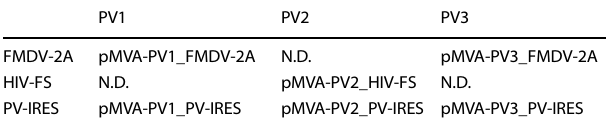
Table 1. Matrix of plasmids tested for transient expression by transfection into GMK cells. Expression of the P1 genes is regulated by the T7 promoter, with the T7 polymerase provided in trans through infection with MVA-T7, whilst that of the downstream 3CD gene is achieved by one of the three strategies listed on the